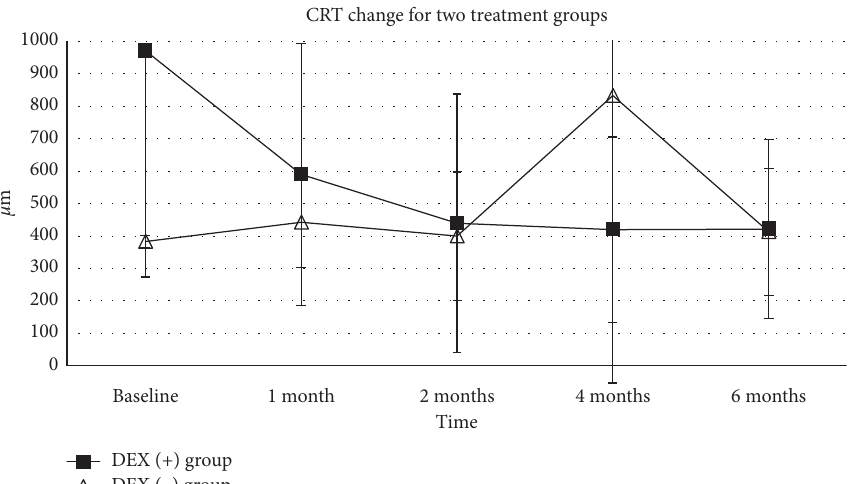
Figure 4: Central retinal thickness (CRT) change for the DEX (+) group and DEX ( − ) group. The CRT at the baseline and 1, 2, 4, and 6 months during the follow-up period is shown in this figure. The change of CRTfor the DEX (+) group was defined with a line chart with solid square, while the change of CRT for the DEX ( − ) group was defined with a line chart with open arrowhead ( ∗ P < 0 . 5, ∗∗ P < 0 . 1, and ∗∗∗ P < 0 .